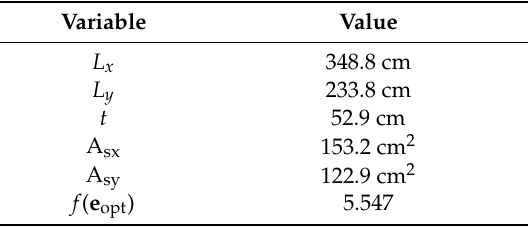
Table 6. Example 1: Optimum design vector and its objective value.